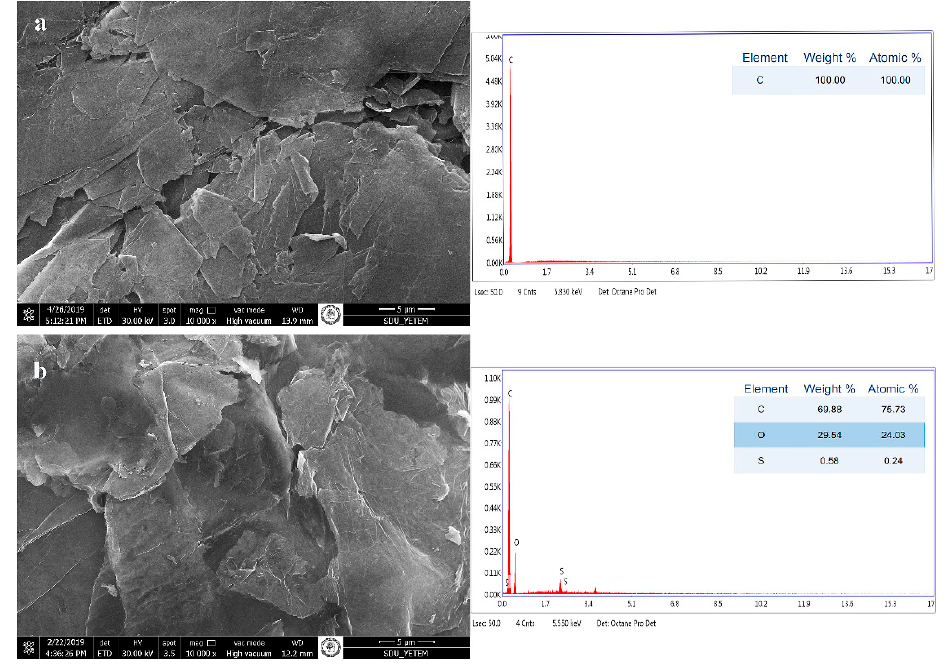
Figure 4. SEM/EDX image of graphite ( a ) and GO ( b ).